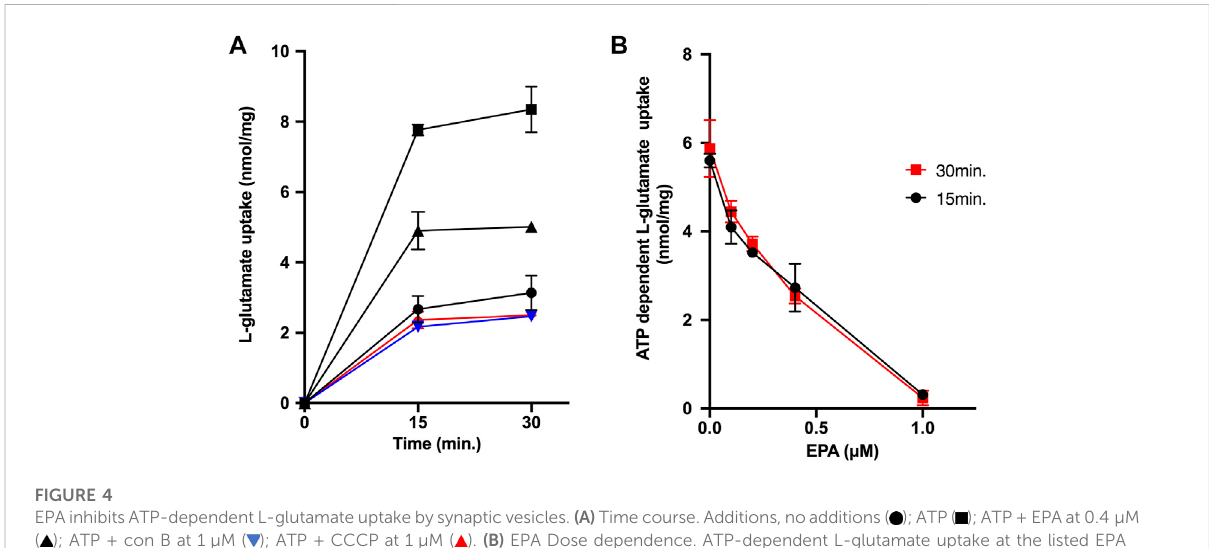
FIGURE 4 EPAinhibitsATP-dependentL-glutamateuptakebysynapticvesicles. (A) Timecourse.Additions,noadditions ( );ATP( );ATP+EPAat0.4 μ M ( ); ATP + con B at 1 μ M ( ); ATP + CCCP at 1 μ M ( ). (B) EPA Dose dependence. ATP-dependent L-glutamate uptake at the listed EPA concentrations at 15 min ( ) or 30 min ( ) were